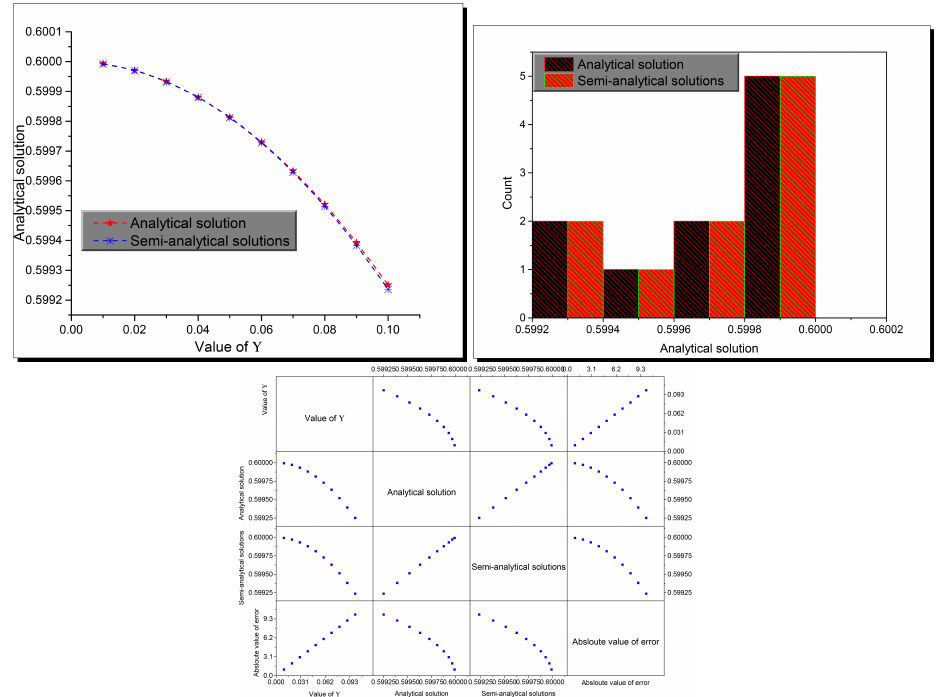
Figure 5. Sketches of Computational and semi-analytical solutions in distinct plots to show the accuracy of the obtained